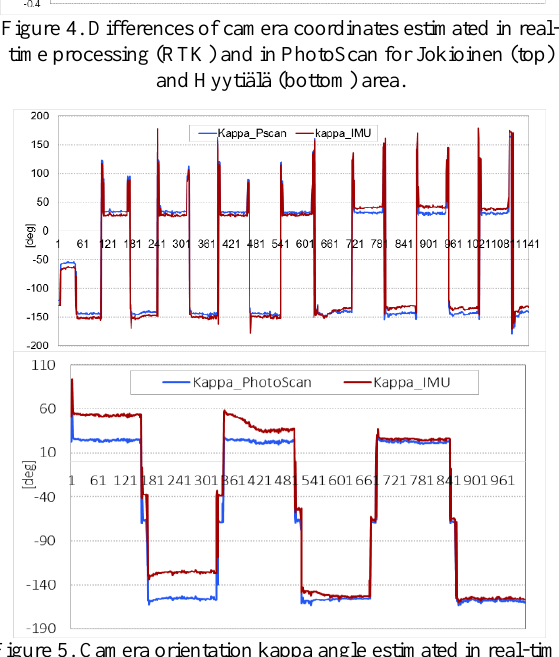
Figure 5. Camera orientation kappa angle estimated in real-time and in PhotoScan for Jokioinen (top) and Hyytiälä (bottom)